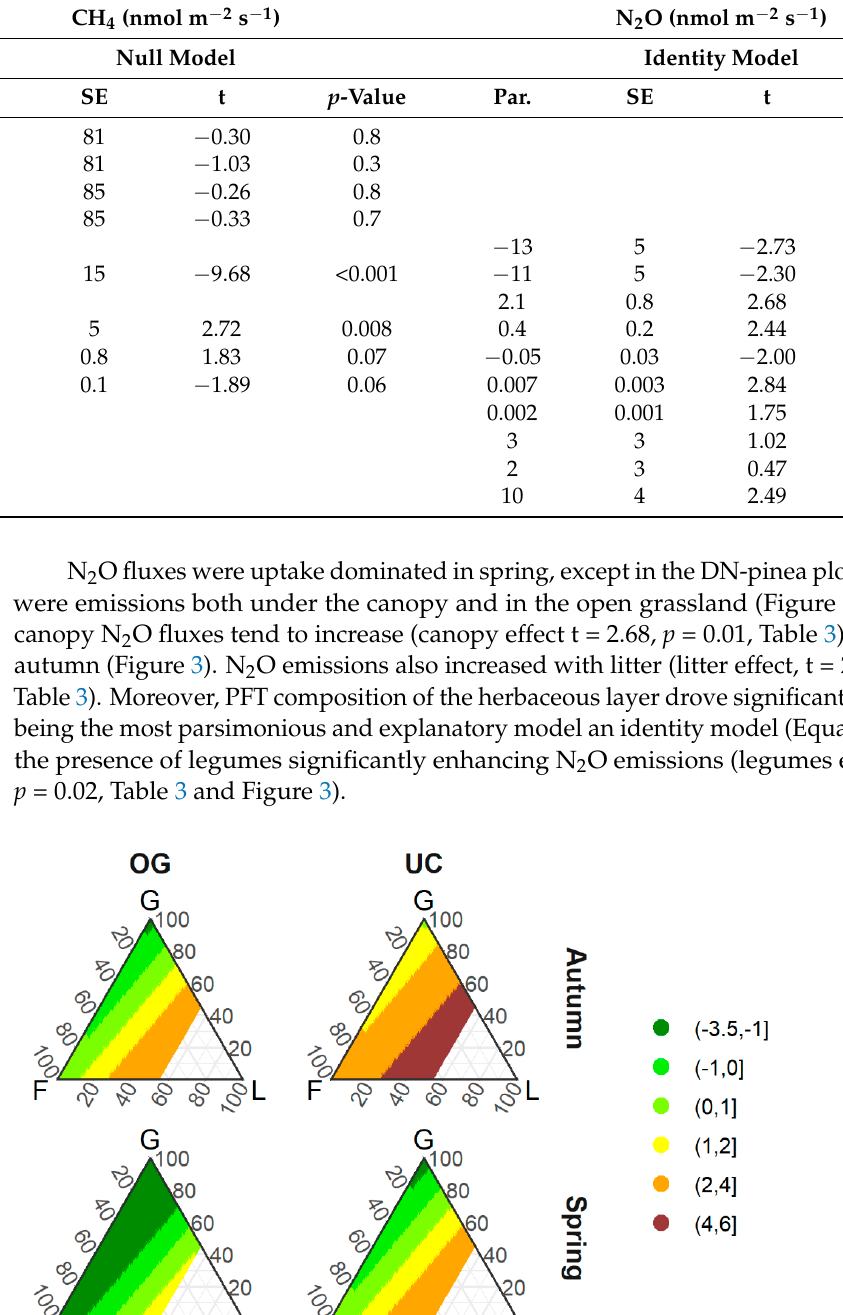
Figure 3. Predicted N 2 O exchange (nmol m − 2 s − 1 ) according to the identity model (Table 3). F indicates forbs, G grasses, and L legumes. Predicted N 2 O modeled with a maximum proportion of legumes of 50%, according to the legumes proportion observed in the field (Figure S3). Negative N 2 O values indicate net uptake, and positive values indicate N 2 O emissions. Environmental conditions set as the mean of the given treatment level. Table 3. CH 4 and N 2 O exchange diversity ‐ interaction model results. CH 4 and N 2 O exchange as function of plot, season, canopy, soil temperature (T s ), soil water content (SWC), litter, below ‐ ground biomass (BGB), and plant functional types (forbs, grasses, and legumes) proportions. Sea ‐ son with spring as reference level, and canopy with open grassland (OG) as reference level. Pa ‐ rameter estimates (Par.), standard error (SE), t, and p ‐ value.